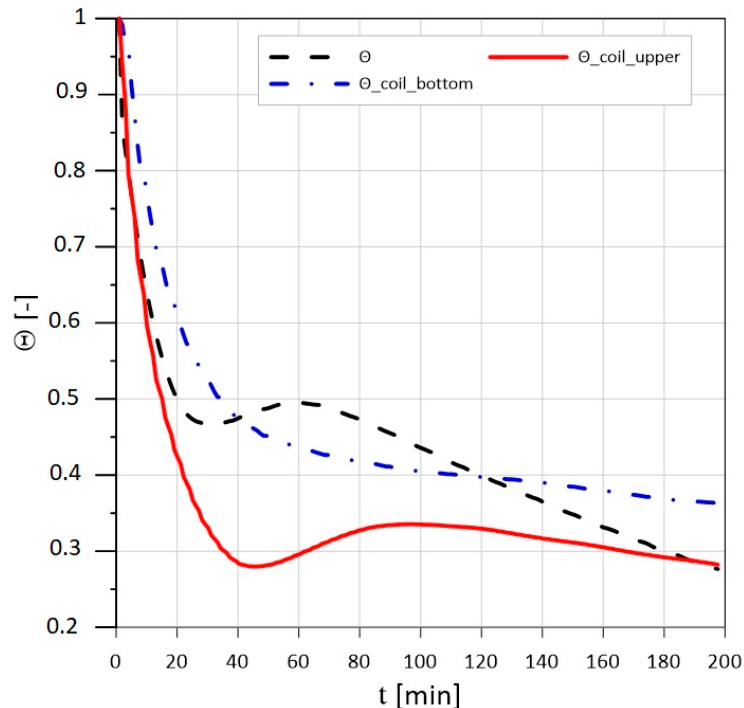
Figure 22. Dimensionless, volume-averaged temperature vs. time during the solidification process with a constant wall temperature condition .